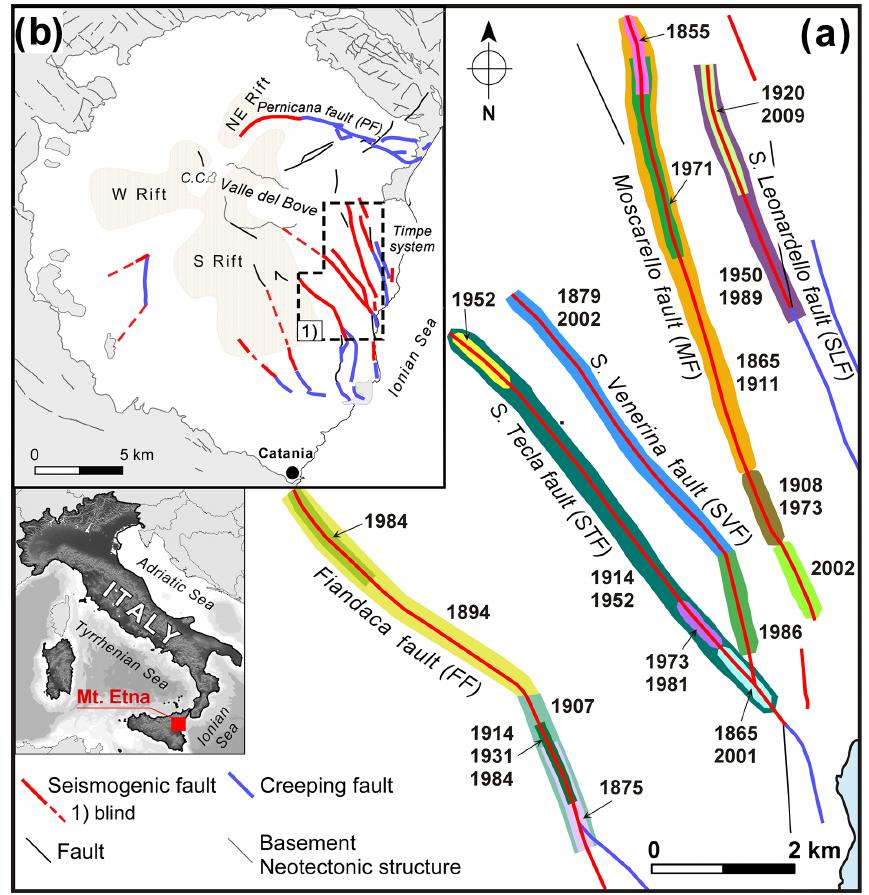
Figure 1. Fault systems in the study area. (a) Patterns of historical surface faulting along the southeastern flank of Mt. Etna (Timpe tectonic system); colors represent coseismic ruptures related to different earthquakes (modified from Azzaro, 1999). (b) Seismotectonic model of Etna (from Azzaro et al., 2012a). The rift zones, i.e., high frequency of opening of eruptive fissures, are in beige; the sedimentary and metamorphic basement underlying the volcano is in